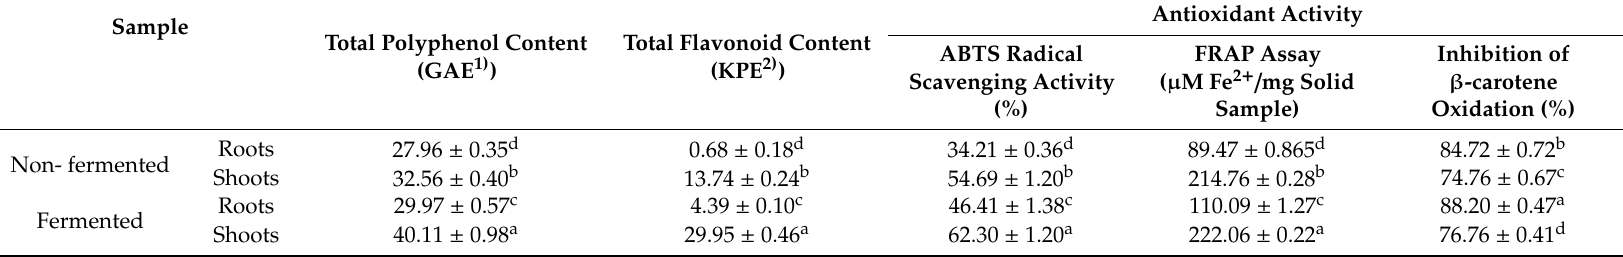
Table 2. Total polyphenol, flavonoid contents, and antioxidant activities of non-fermented and fermented hydroponic